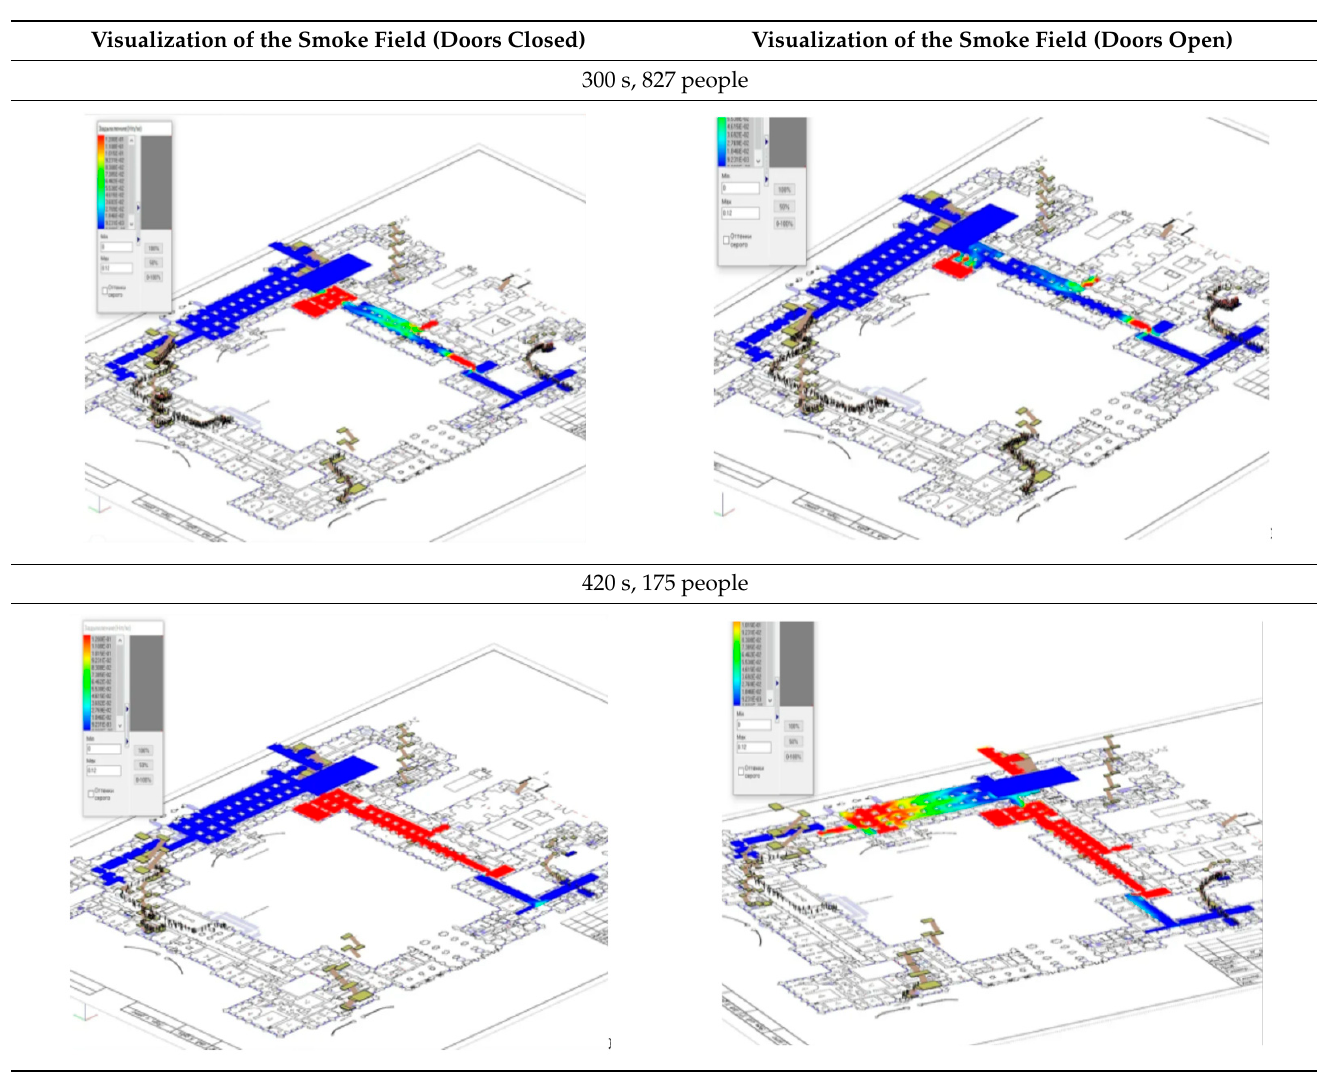
Figure 12. Doors (1, 2 and 3), which are controlled (staff closes these doors) during the fire ( a ); door 1—between Jordan and Rastrelli galleries ( b ); door 2—between the Rastrelli gallery and the room of the Art of Palmira ( c ). Doors 1, 2, and 3 after the last person leaves the Rastrelli Gallery are taken in the calculation to be closed, and the spread of fire hazards to adjacent rooms occurs only through a gap with a width of 3 cm, which simulates the leakage of the vestibule. Table 2 presents the horizontal slices of smoke at a height of 1.7 m from the floor (the average level of human respiratory organs [2]), allowing the assessment of its dynamics in two different conditions. The color of the field changes from blue (safe) to red (danger- ous), the critical value of the optical density (smoke produced by the flaming combustion of a certain amount of solid matter) of smoke is 0.12 Np/m [2]. Table 2. Visualization of evacuation and smoke (optical density, Np/m) at the height of 1.7 m from the floor at 300, 420, 480, and 530 s from the beginning of the fire in the scenario “The fire in Buffet (Rastrelli Gallery)”.